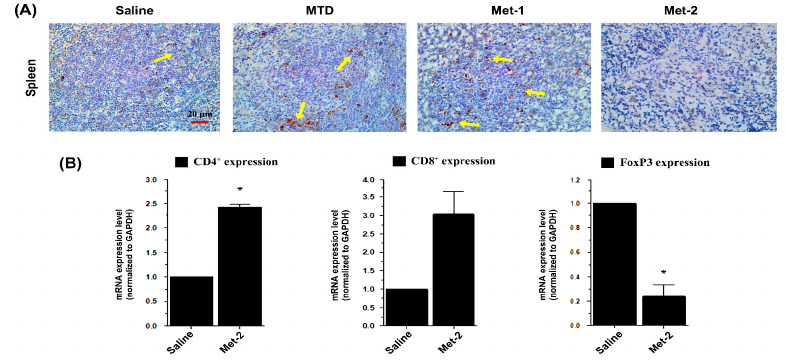
Figure 7. Immunomodulatory e ff ect of cyclophosphamide. ( A ) Immunohistochemistry for